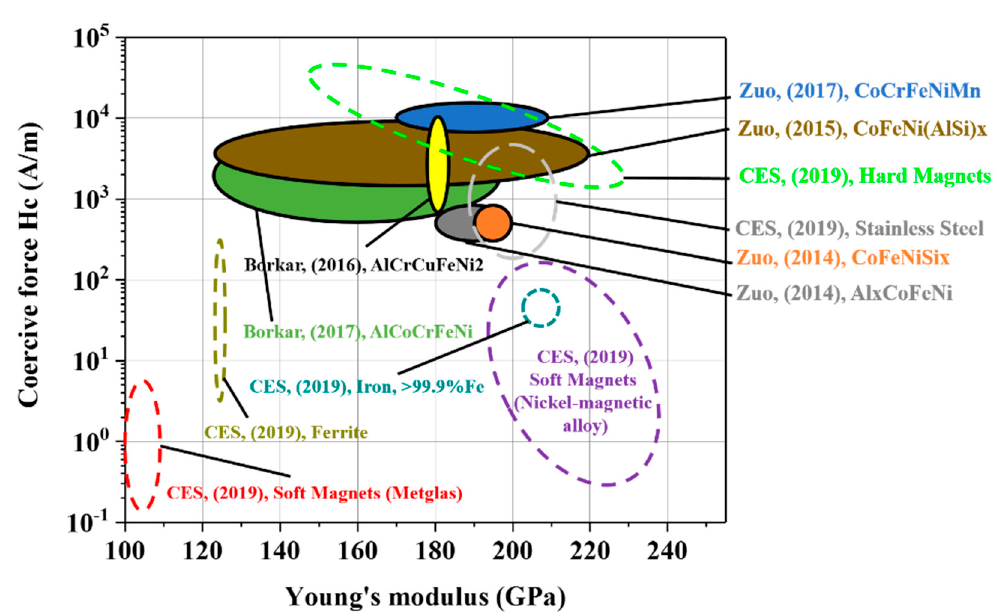
Figure 5. Coercive force vs. Young’s modulus for conventional alloys (encircled by dashed lines) and HEAs (colored regions encircled by solid lines). (Data taken from [27,29,34,35,40,43,75,76,78,80]). The data is from the CES EduPack 2009, Granta Design, Limited, Cambridge, UK, 2009.